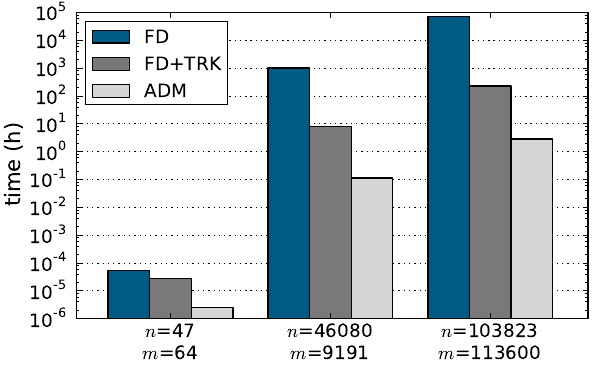
Fig. 24. A comparison of computation time for the calculation of one Jacobian matrix using different methods. Three different problems representing single-target 1-D, 2-D and 3-D problems are used as example. The method “FD” uses finite differences without any optimisation. The method “FD+TRK” exploits the sparsity of the Jacobian matrix to calculate only the non-zero entries with finite differences. The method “ADM” uses algorithmic differentiation. No parallelisation was employed.